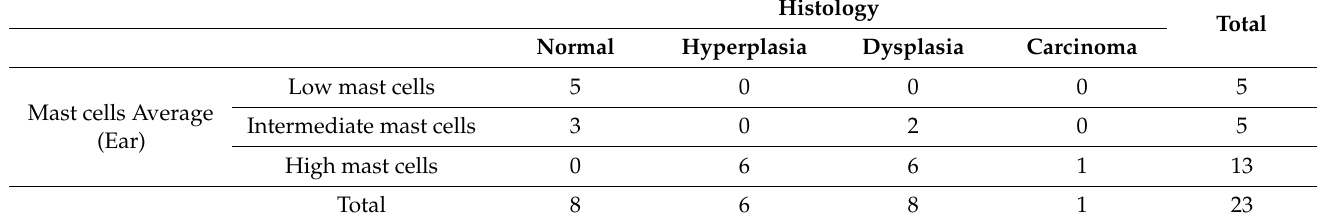
Table 4. Kruskal–Wallis test for the normalized relative expression of the four microRNAs along mast cell count.